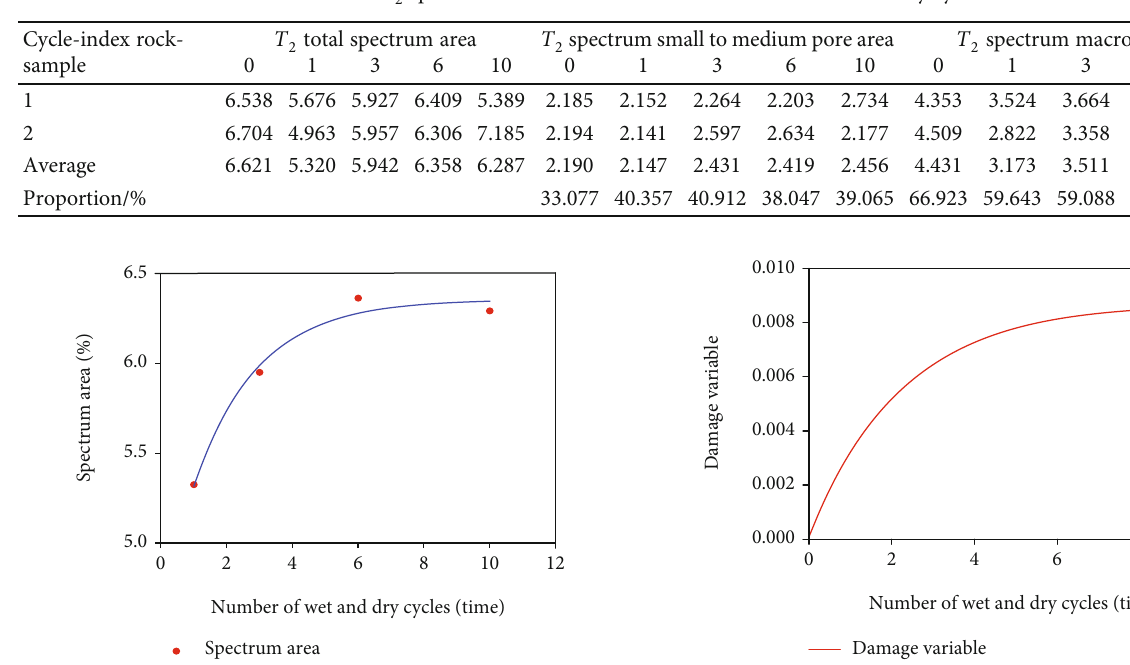
Table 2: T 2 spectral areas of red sandstone after di